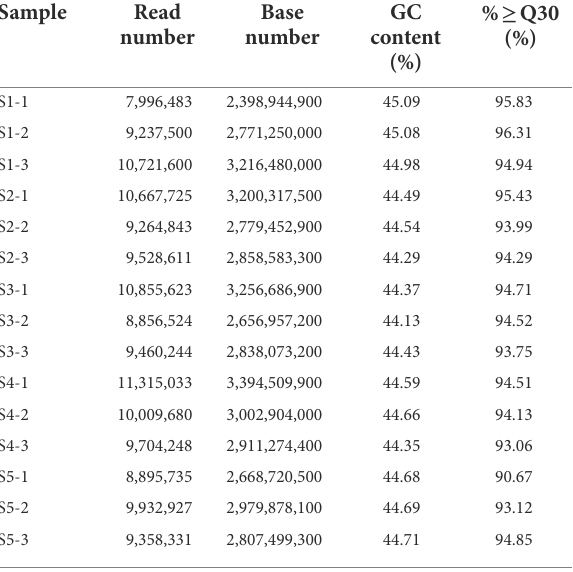
TABLE 1 Summary of RNA-seq data and the reads mapped to the Bacillus subtilis 1JN2 genome.